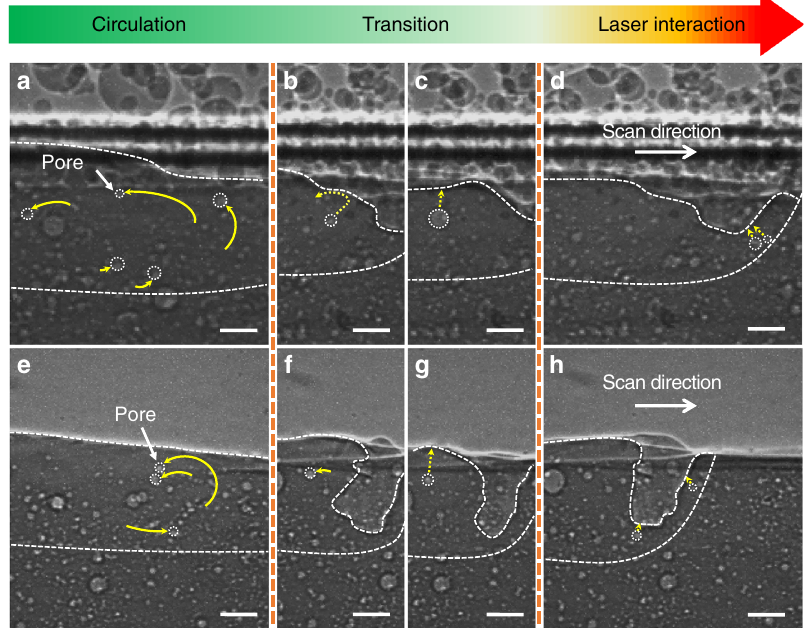
Fig. 2 Dynamic pore motions within melt pool. a – d X-ray images showing pore dynamics during the LPBF process. The thickness of powder layer is 100 μ m. e – h X-ray images showing pore dynamics during laser melting of a bare substrate. Dotted arrows indicate the future trajectories of the pores, while solid arrows mark the history of pore trajectories. Pores follow circular patterns at the circulation domain ( a , e ), while pores in the laser interaction domain move toward depression zone and escape from the melt pool ( d , h ). In the transition domain ( b , c , f and g ), pores exhibit irregular moving behavior, sometimes moving toward the melt pool surface and escaping ( c , g ), and sometimes circulating in the melt pool ( b , f ). The laser beam diameter ( D 4 σ ) is 100 μ m, the laser power is 360 W, and the scan speed is 1 m s − 1 . All scale bars are 50 μ